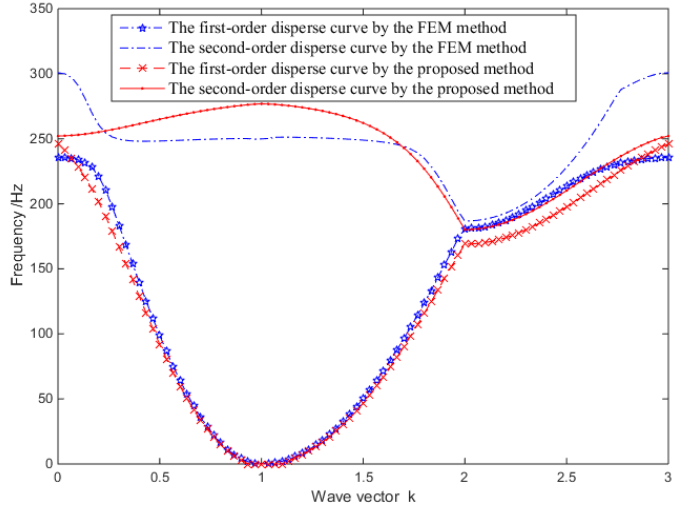
Figure 6. The dispersion curves under configuration A.